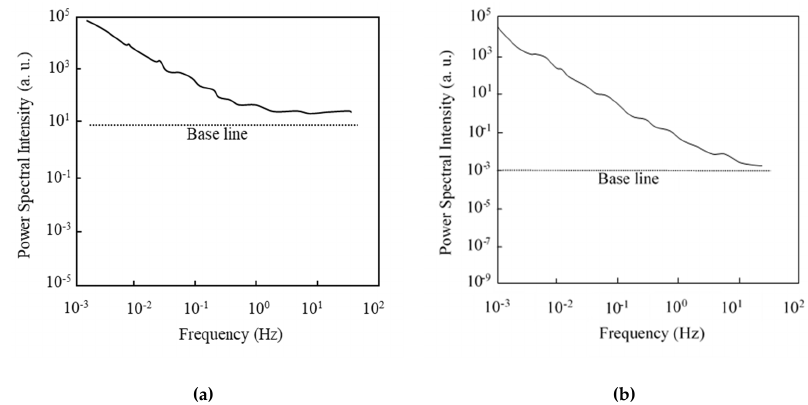
Figure 7. Power spectral intensity of 100-nm-long gate SOI MOSFETs at the subthreshold bias. ( a ) nMOSFET ( V D = 0.1 V, V G = –0.6 V, V sub = 0 V), ( b ) pMOSFET ( V D = –0.1 V, V G = –0.4 V, V sub = 0